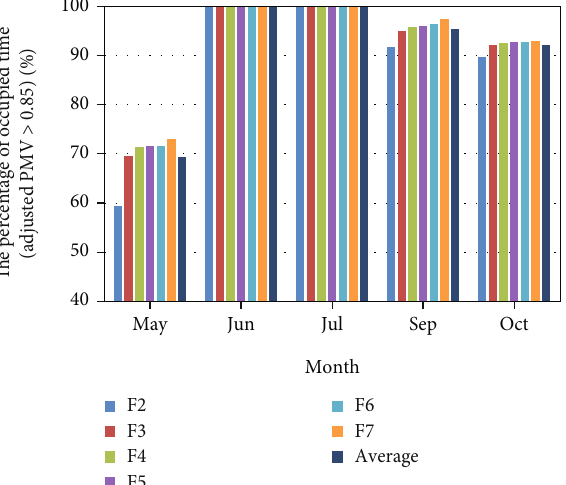
Figure 11: Monthly average temperature.